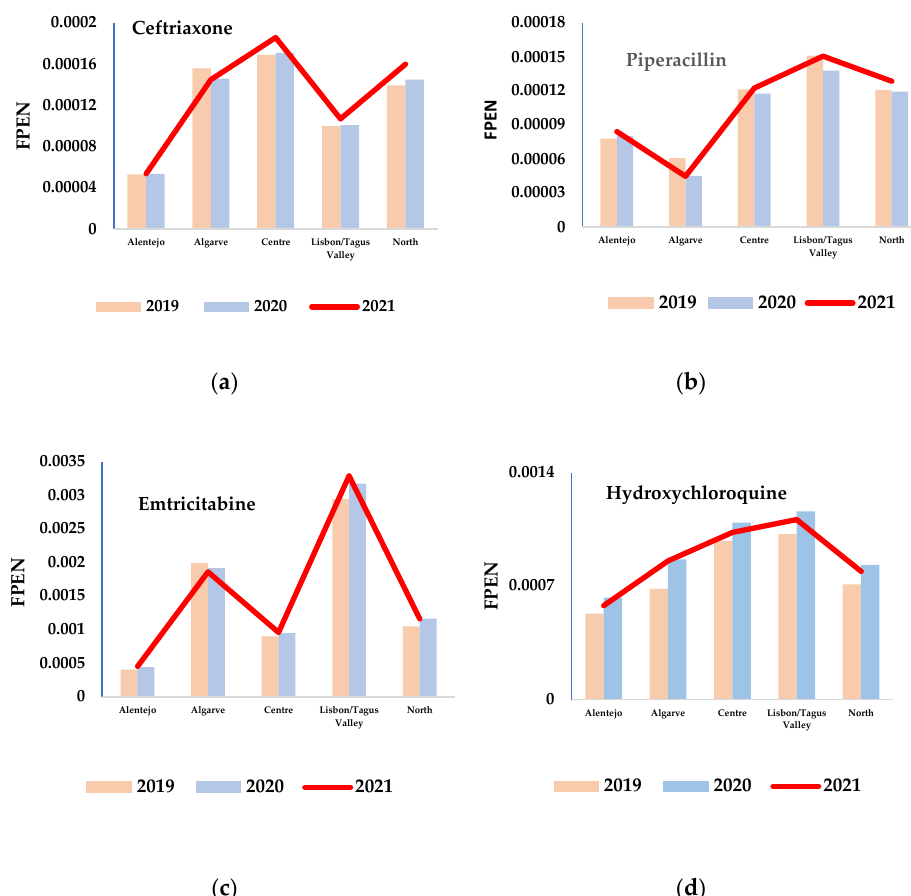
Figure 2. Different trends and patterns of Fpen for four active substances: ( a ) ceftriaxone (antibiotic), ( b ) piperacillin (antibiotic), ( c ) emtricitabine (antiviral), and ( d ) hydroxychloroquine (antimalarial) during the study period (2019–2021).